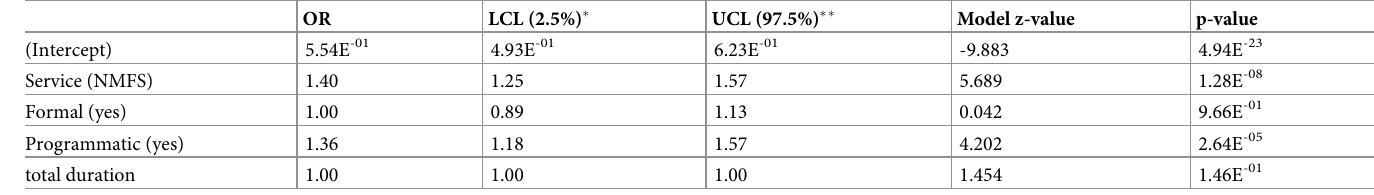
Table 4. Odds ratios (OR), confidence intervals, and parameter statistics for model 9, the best-supported candidate set for predicting overall consultation completeness.